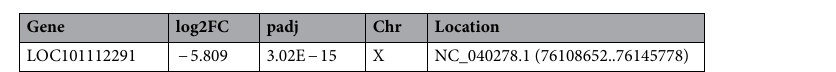
Table 2. ncRNA differentially expressed between the control female and control male fetal LV tissue. ncRNA genes in the female control compared to the male control and enriched at adjusted-p value (padj) < 0.05 and absolute log2 fold change (log2FC) > 0.5 are represented. Genes highly expressed in the female fetal LV tissue are represented as negative values. Among all classes only one lncRNA was differentially expressed in the female fetal LV tissue compared to the male fetal LV